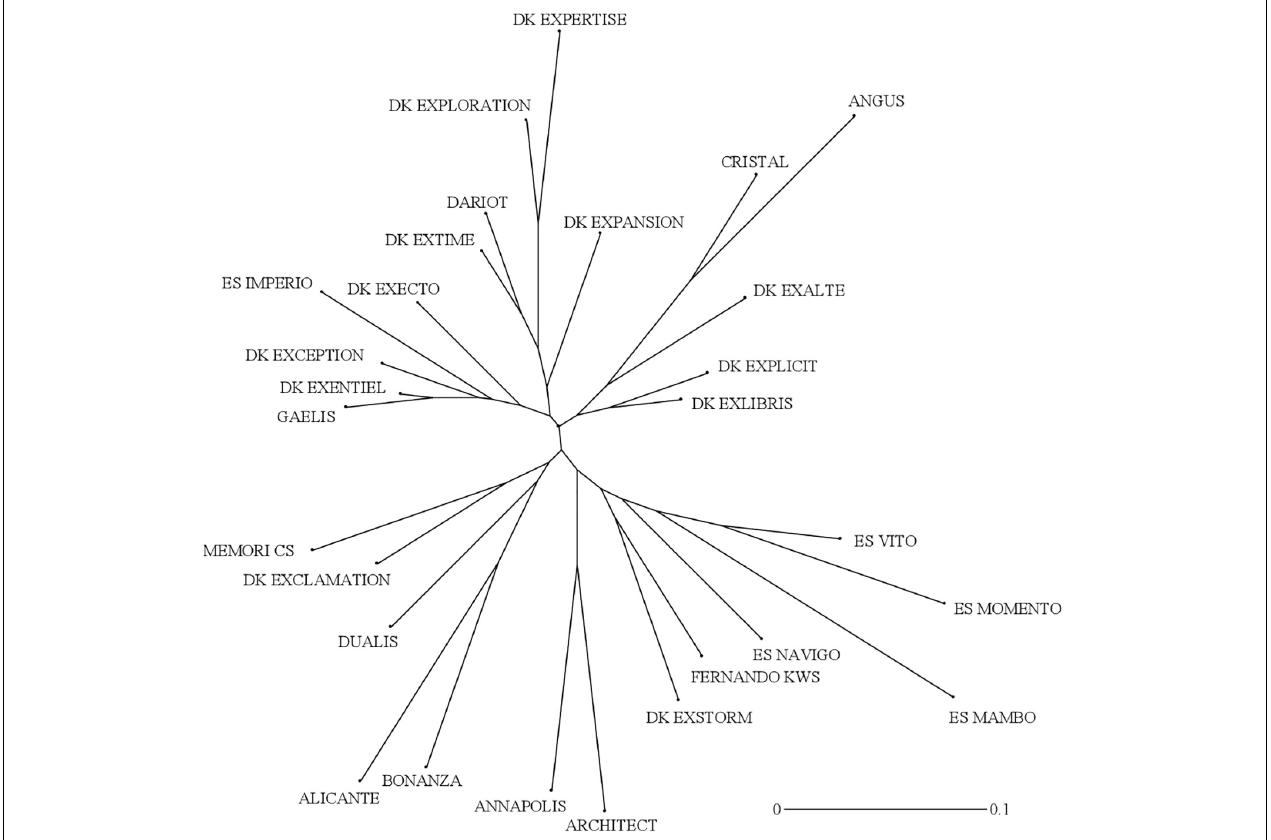
FIGURE 6 | Unweighted Neighbor-Joining (NJ) radial tree showing genetic interrelationships of 28 winter oilseed rape cultivars. The pairwise comparisons were based on dissimilarity coefficients computed from simple matching of allelic data using 17 SSR